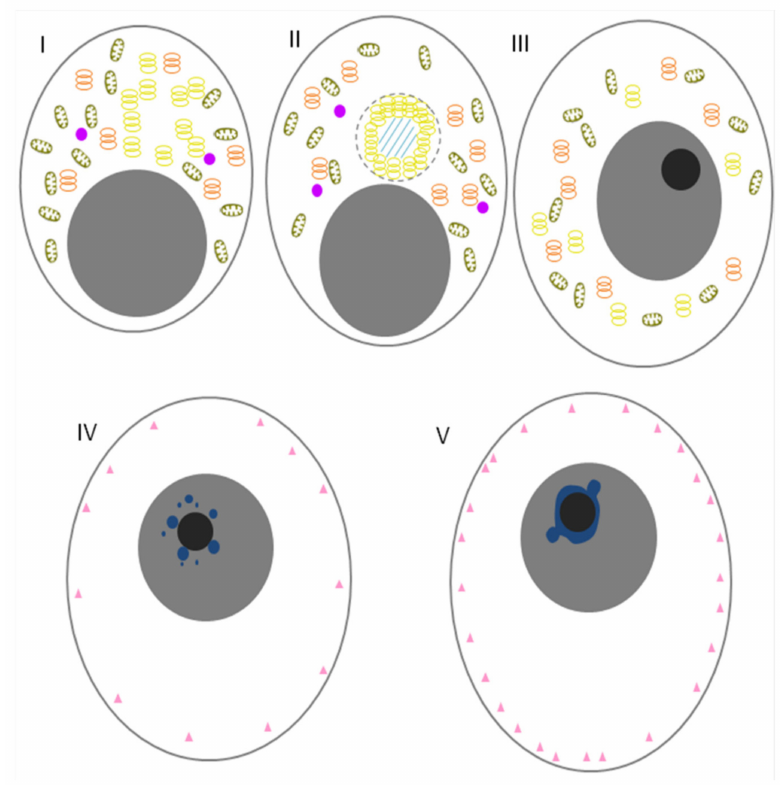
Figure 4. Schematic diagram of the Golgi ring of mice. ( I ) An oogonium within a germline cyst. ( II ) An oocyte within a primordial follicle shows a well-defined Golgi ring surrounding the mitochondrial exclusion zone (MEZ). ( III ) An oocyte within a primary follicle with mitochondria and ER, evenly distributed throughout the cytoplasm. ( IV ) NSN GV oocyte. ( V ) SN GV oocyte. Germ cells are outlined with grey, and nuclei are shown as closed grey circles. Germ granules/nuage (closed purple circles). Mitochondria (brown ellipse). Golgi (yellow rings). Endoplasmic reticulum (ER) (orange rings). Subcortical aggregates (pink triangle). Condensed chromatin (Blue). In II, the Golgi ring is marked with a dashed line. MEZ is marked with